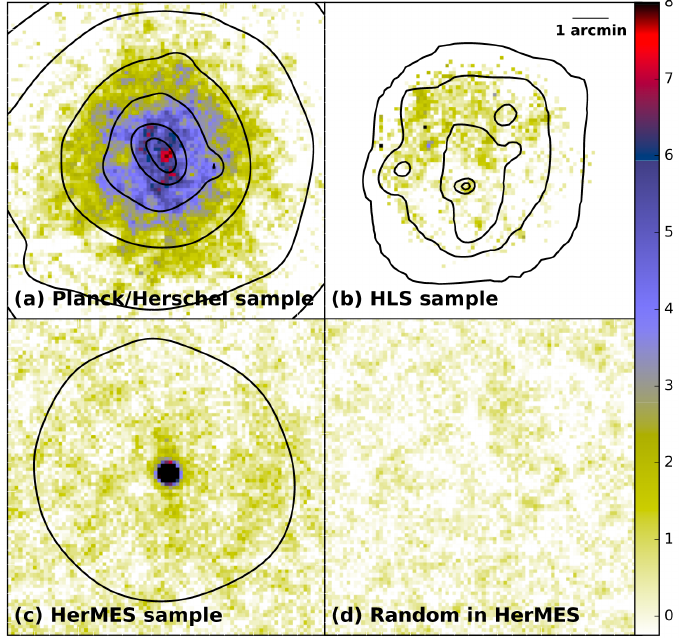
Figure 3. ( a ) Herschel SPIRE 350 µ m stacking of 228 Planck PHz cold sources [229]. Extended emission is seen over the 8.7 (cid:48) × 8.7 (cid:48) cutout, consistent with these sources being proto-cluster candidates. For comparison, panel ( b ) shows the stacking of 278 z < 1 Herschel Lensing Survey clusters [358], ( c ) single 500 µ m sources from HerMES 16 , and ( d ) shows 500 random positions in the HerMES Lockman field. Figure reproduced from Figure 12 in Planck Collaboration et al. [280], with permission from